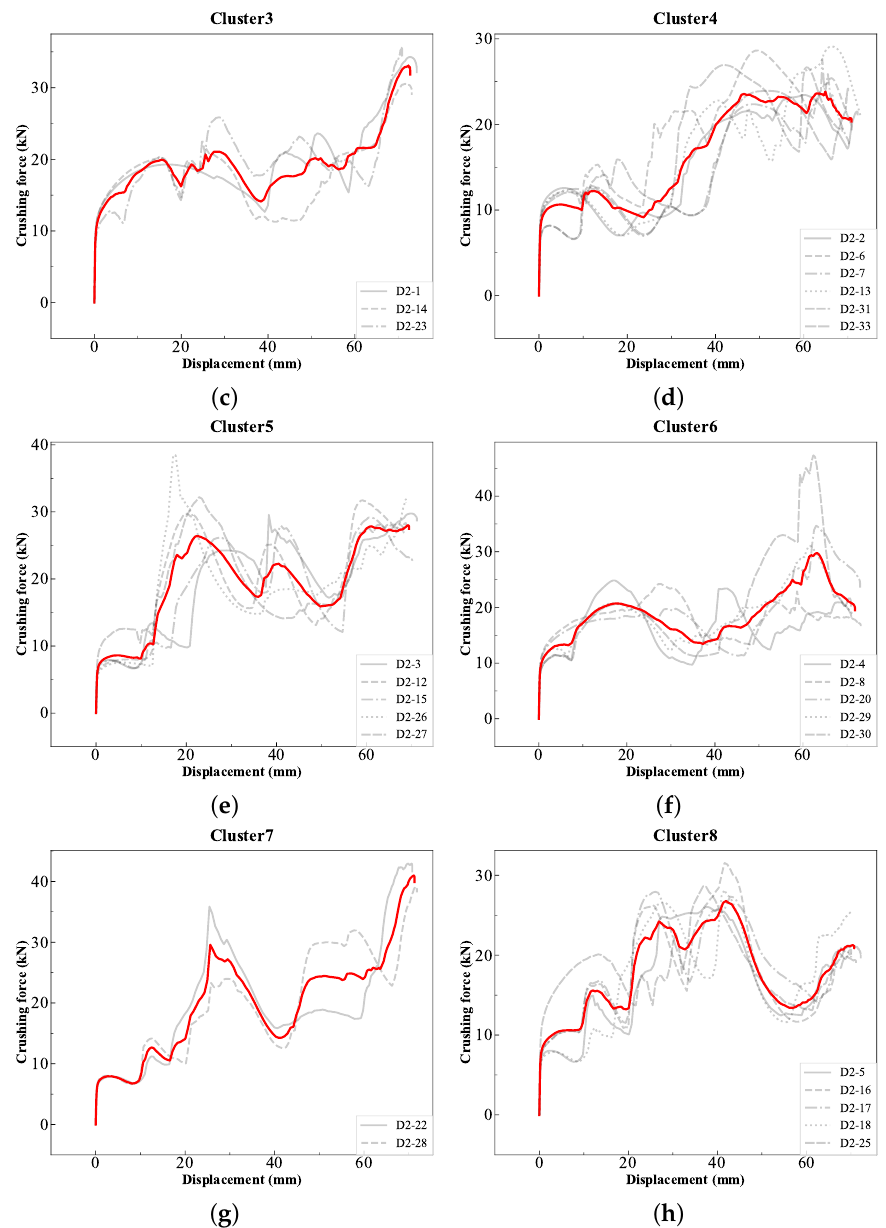
Figure 11. Clustering results of course curves at k = 8: ( a ) Cluster 1; ( b ) Cluster 2; ( c ) Cluster 3; ( d ) Cluster 4; ( e ) Cluster 5; ( f ) Cluster 6; ( g ) Cluster 7; ( h ) Cluster 8. The red lines in each picture are the curves of the centroids of each